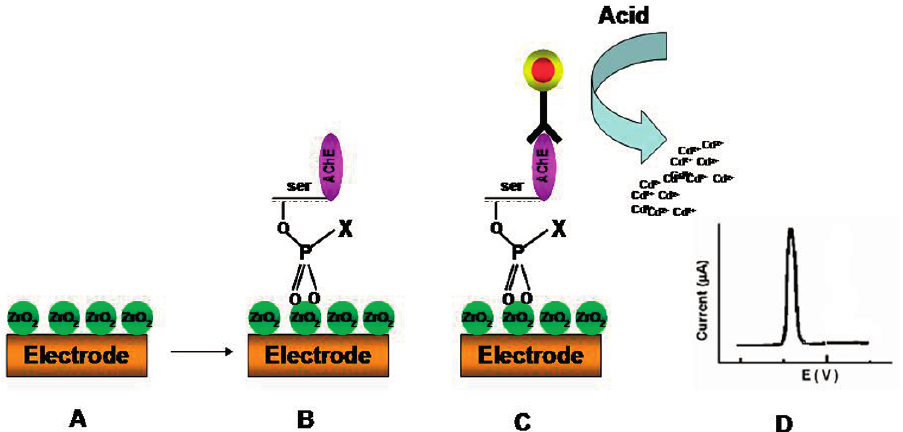
Figure 10. Electrochemical immunosensing of phosphorylated AChE using a ZrO 2 NP-modified SPE ( A ) with selective capturing of phosphorylated AChE adducts ( B ) and detection via ( C ) Immunoreaction between bound phosphorylated AChE adducts and QD-labeled anti-AChE antibody ( D ) Representative voltammogram (reprinted with permission from